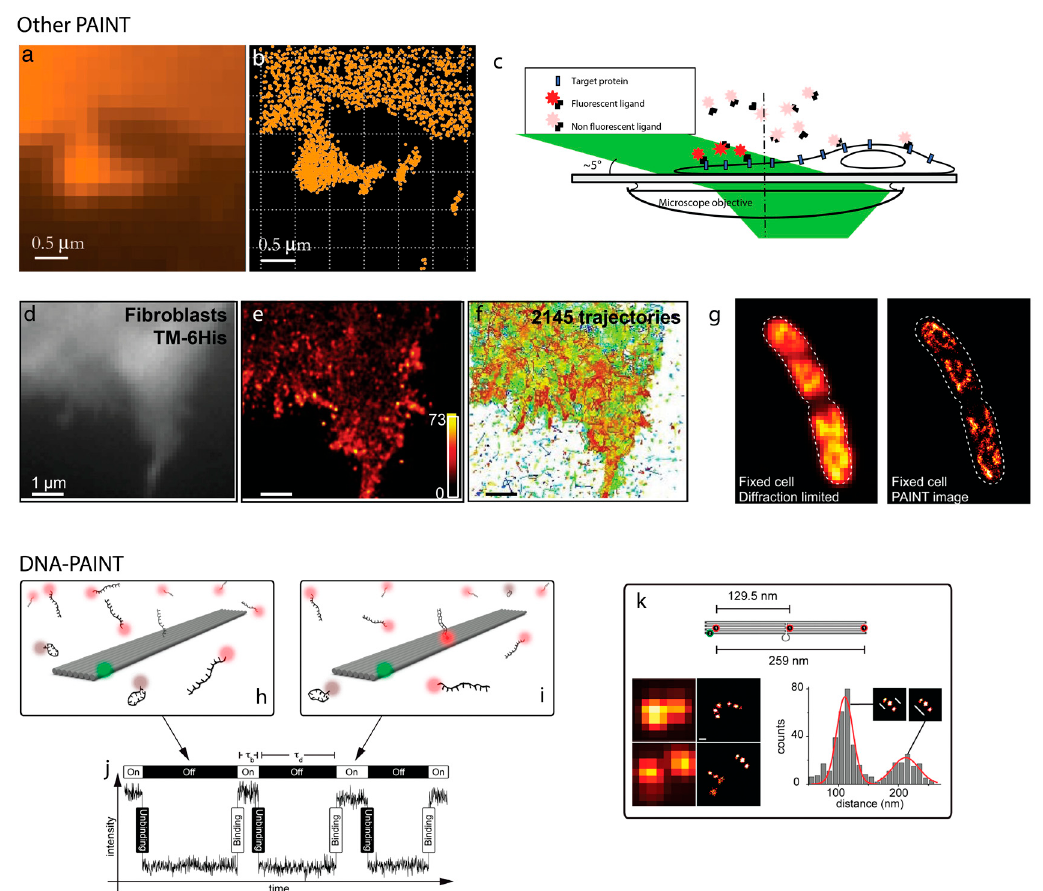
Figure 1. Examples of point-accumulated imaging for nanoscale topography (PAINT). ( a ) Initial implementation of PAINT from [10] showing raw fluorescence image from Nile Red imaging of a supported bilayer and ( b ) high-resolution image by the localization of 2778 single Nile Red probes collected in 4095 frames. ( c ) Schematic of universal PAINT (uPAINT) imaging showing exchange of sub-populations of fluorescent ligands, and super-resolution imaging ( d ) of TM-6His, transmembrane domain of the PDGF receptor fused to a six-histidine (6His) tag on its extracellular side, using 2045 trajectories ( e ). ( f ) Super-resolution PAINT imaging of green fluorescent protein (GFP)-Fis using JF646-Hoechst after 30 min FA fixation, adapted from [15]. ( g ) Schematic of DNA-PAINT. A DNA origami tile is marked with a green fluorophore and the docking strand (center of tile) is imaged when the imager-strand (red fluorophore) is transiently bound to the docking strand and, thus, the tile ( h ). Intensity versus time plots the time between binding events can be resolved ( i ). DNA-PAINT used to resolve the spatial separation of multiple docking sites ( j ). Images in ( b – e ) adapted from [11]; in ( g – j ) adapted from [17].